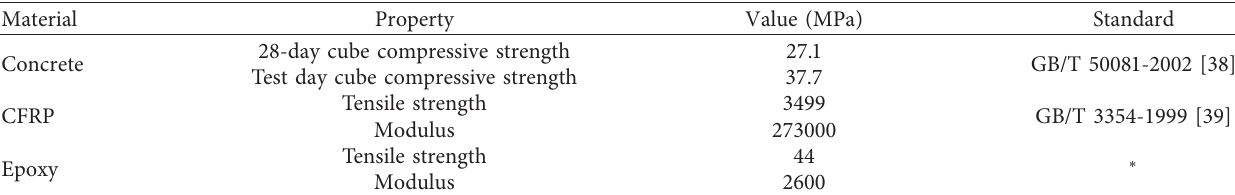
Table 2: Material property